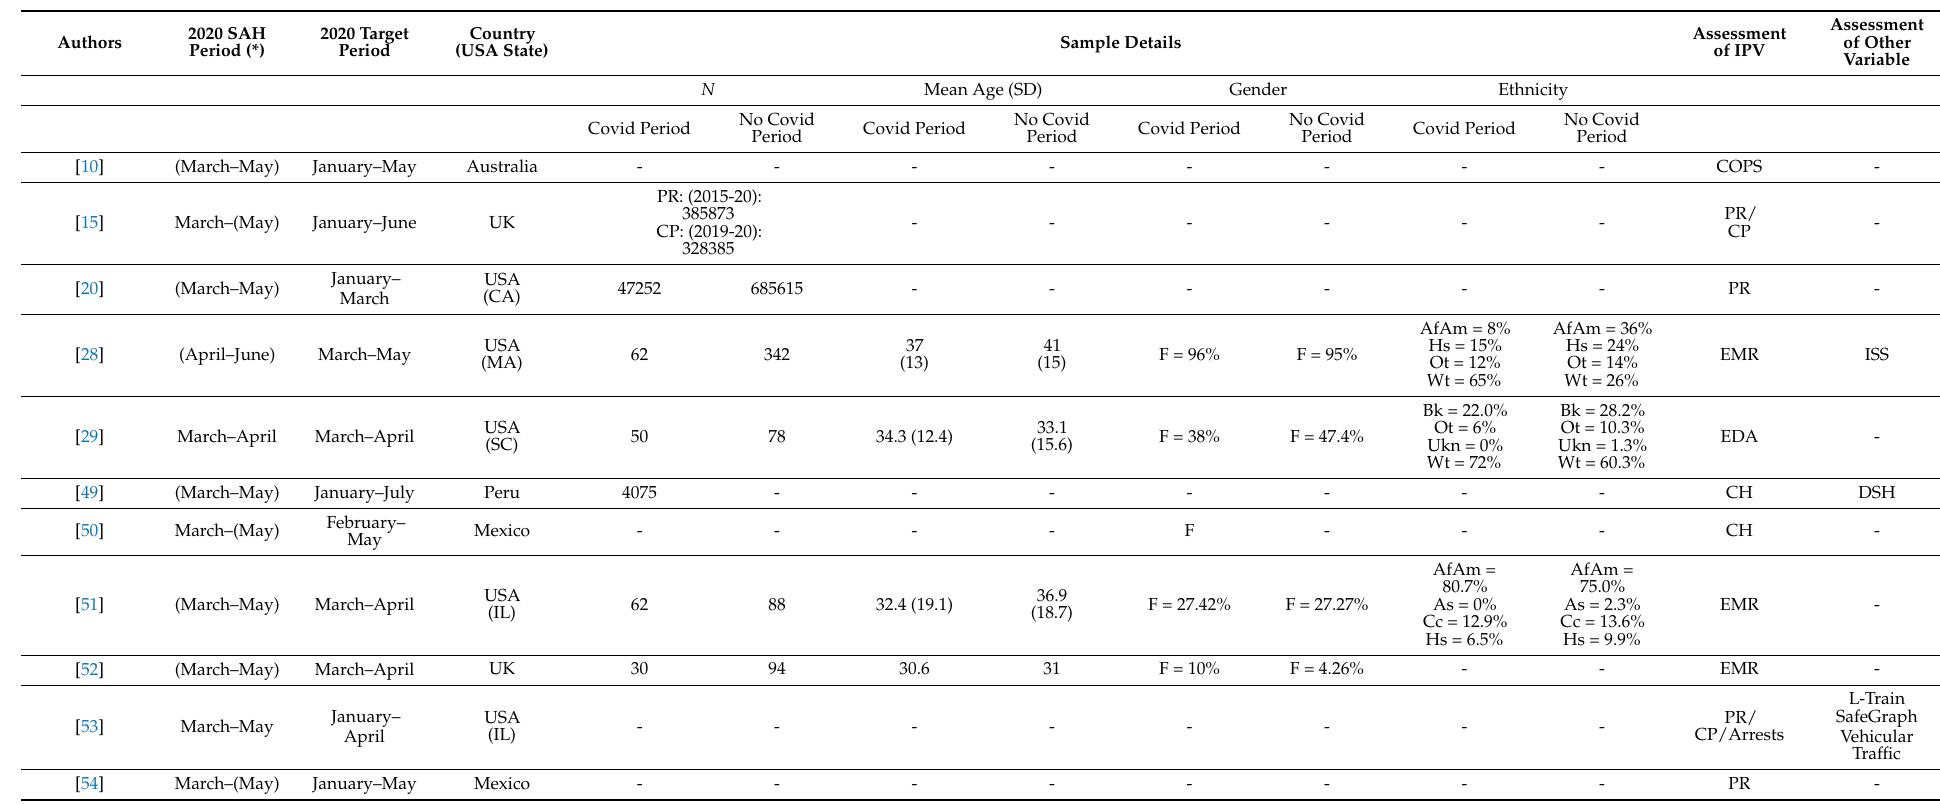
Table 4. Coding Official